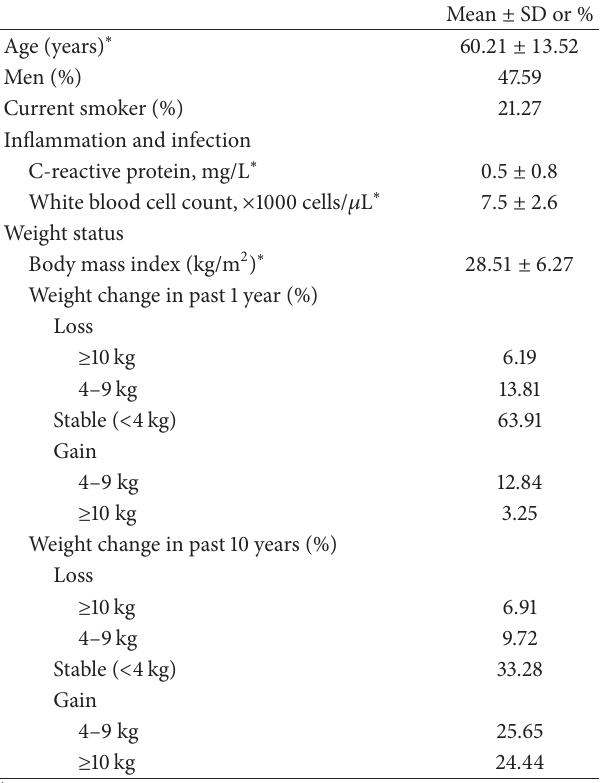
Table 1: Characteristics of persons age 40 and older in the US NHANES 2005–2008 ( 𝑛 =